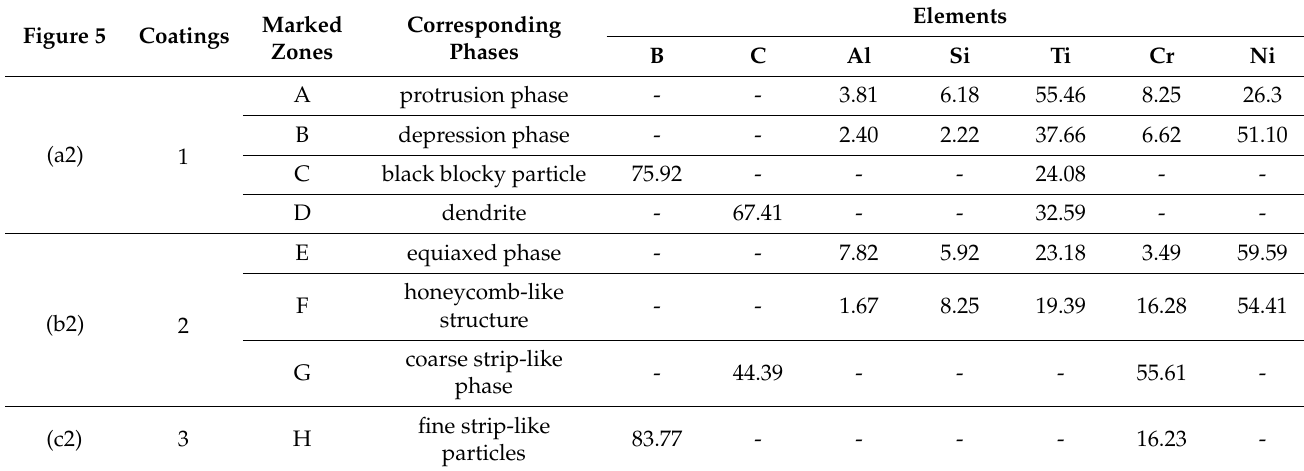
Table 2. EDS results of different zones in the coatings in Figure 5 (at.%). Figure 5 Coatings